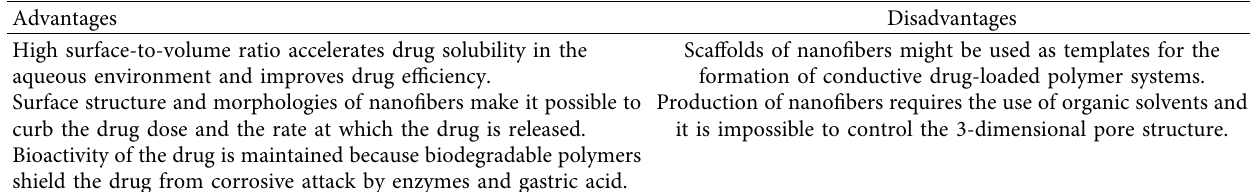
Table 1: Advantages and disadvantages of nanofibers as drug-carrying agents [43, 44].